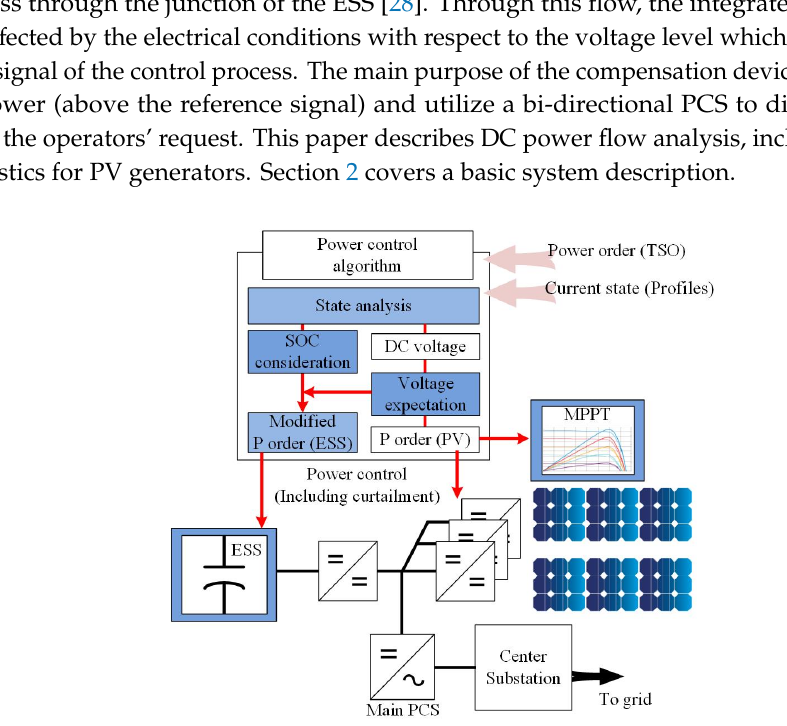
Figure 1. A megawatt (MW) ‐ scale photovoltaic/energy storage system (PV/ESS) for common direct current (DC) configuration.